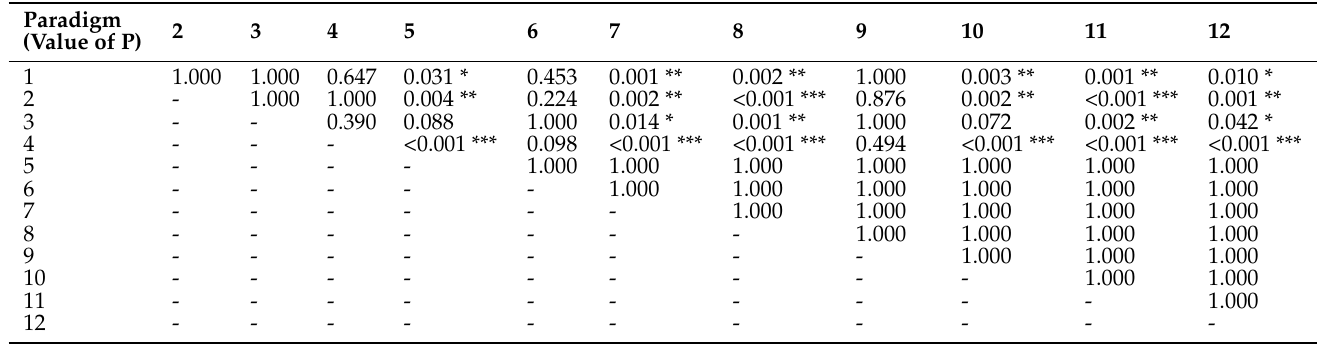
Table A5. Bonferroni Post-Hoc Analysis of Pupil Diameter at Fatigue Level 4 among Twelve Paradigms.